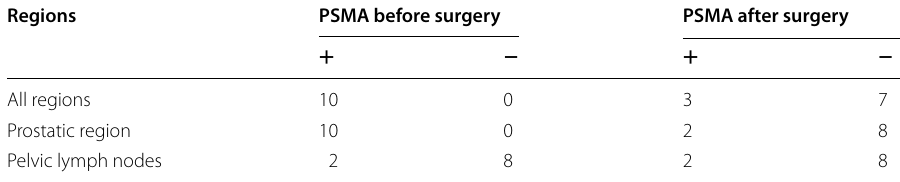
Table 3 Summary of results